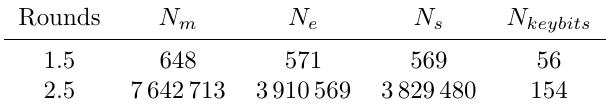
Table 4: Maximum number of monomials present in the system for state-bit 32. N m is the total number of monomials, N e is the number of monomials needed to evaluate for each plaintext, N s is the maximum number of monomials present in the system after evaluation and N keybits is the effective number of (equivalent) keybits